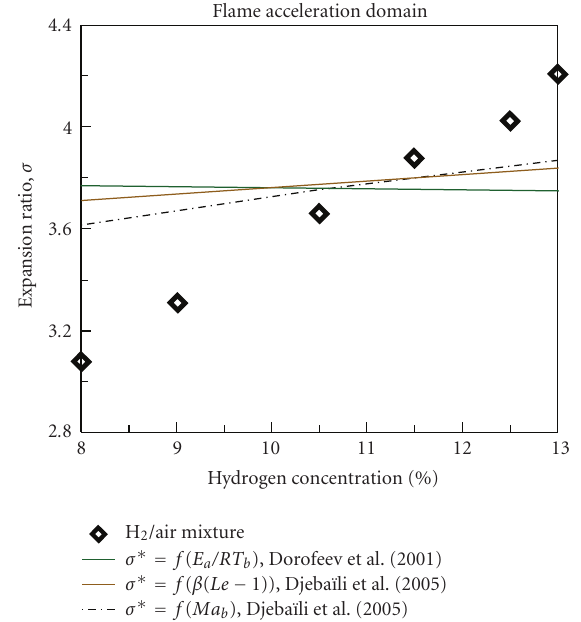
Figure 2: Critical value σ ∗ as a function of hydrogen concentration.